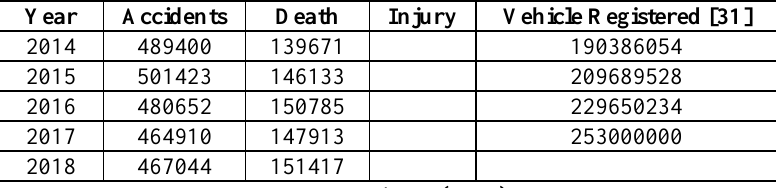
Table 8: Road safety scenario.